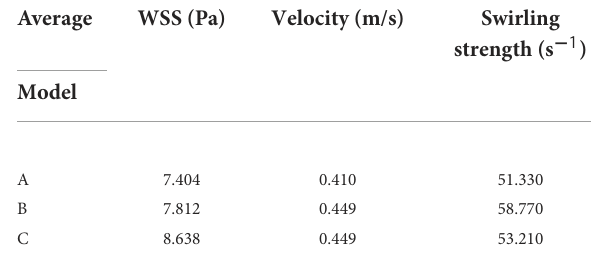
TABLE 2 Average values of WSS, velocity, and swirling strength for the three